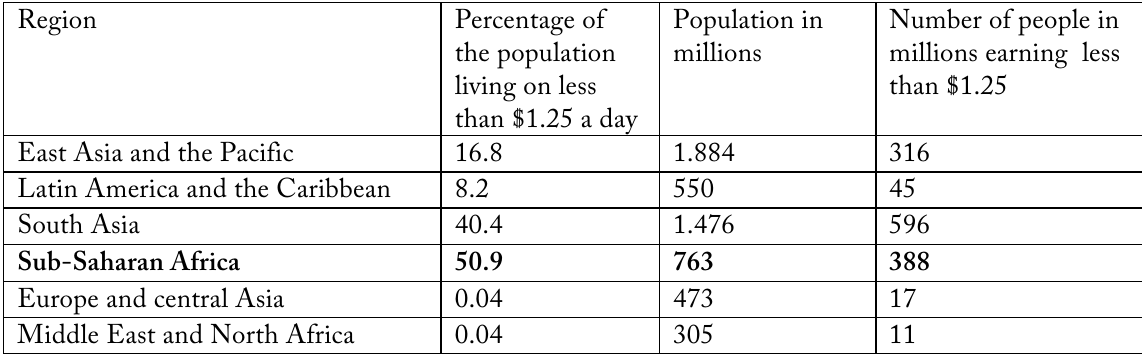
Table 1: Regions of extreme poverty in the world Source: World hunger education service 2011:8 and World Bank